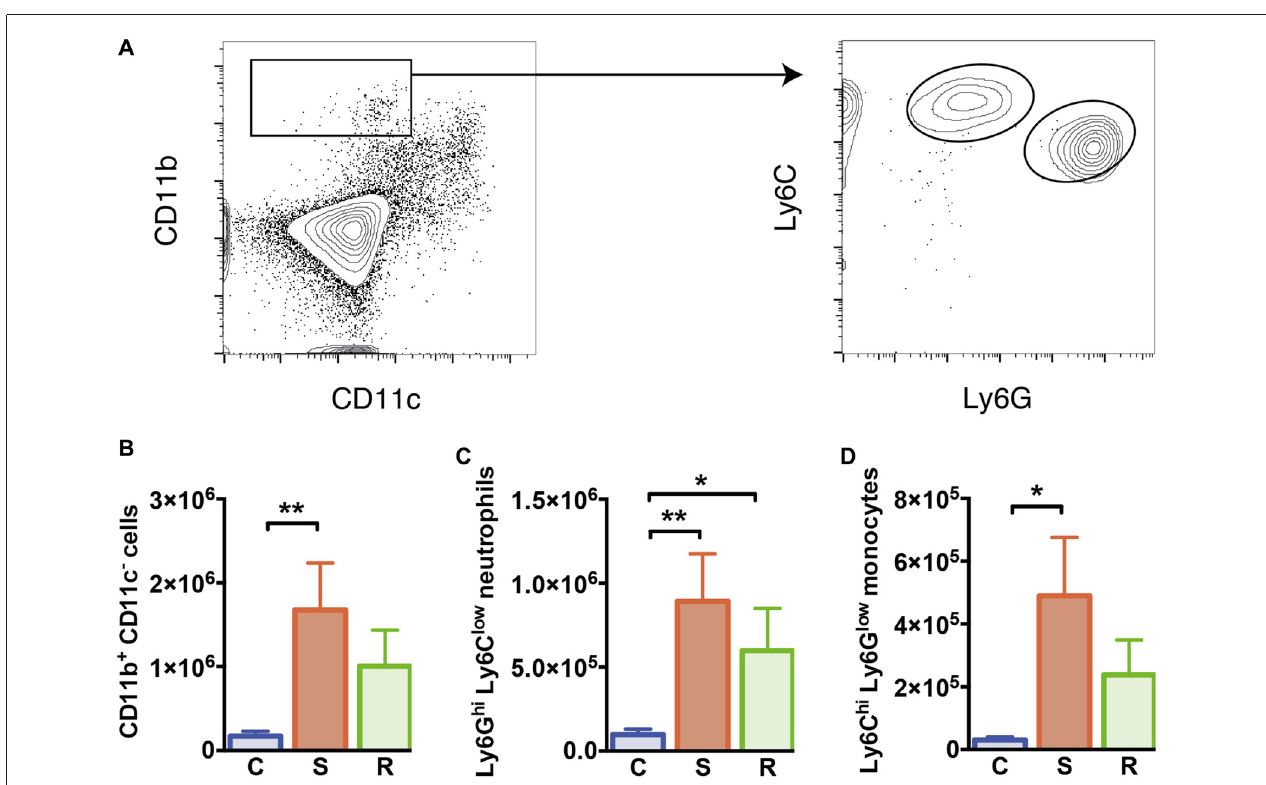
FIGURE 3 | Monocytes and neutrophils in the spleen. (A) Gating of CD11b + CD11c − myeloid cells, Ly6C hi Ly6G low inflammatory monocytes, and Ly6G hi Ly6C low neutrophils. (B) Increased numbers of CD11b + CD11c − myeloid cells in susceptible mice. (C) Increased numbers of Ly6G hi Ly6C low neutrophils in socially defeated mice. (D) Increased numbers of Ly6C hi Ly6G low inflammatory monocytes in susceptible mice. Bar graphs represent mean + SEM. C, control; S, susceptible; R, resilient. n C = 10, n S = 11, n R = 9. ∗ p < 0.05, ∗∗ p <